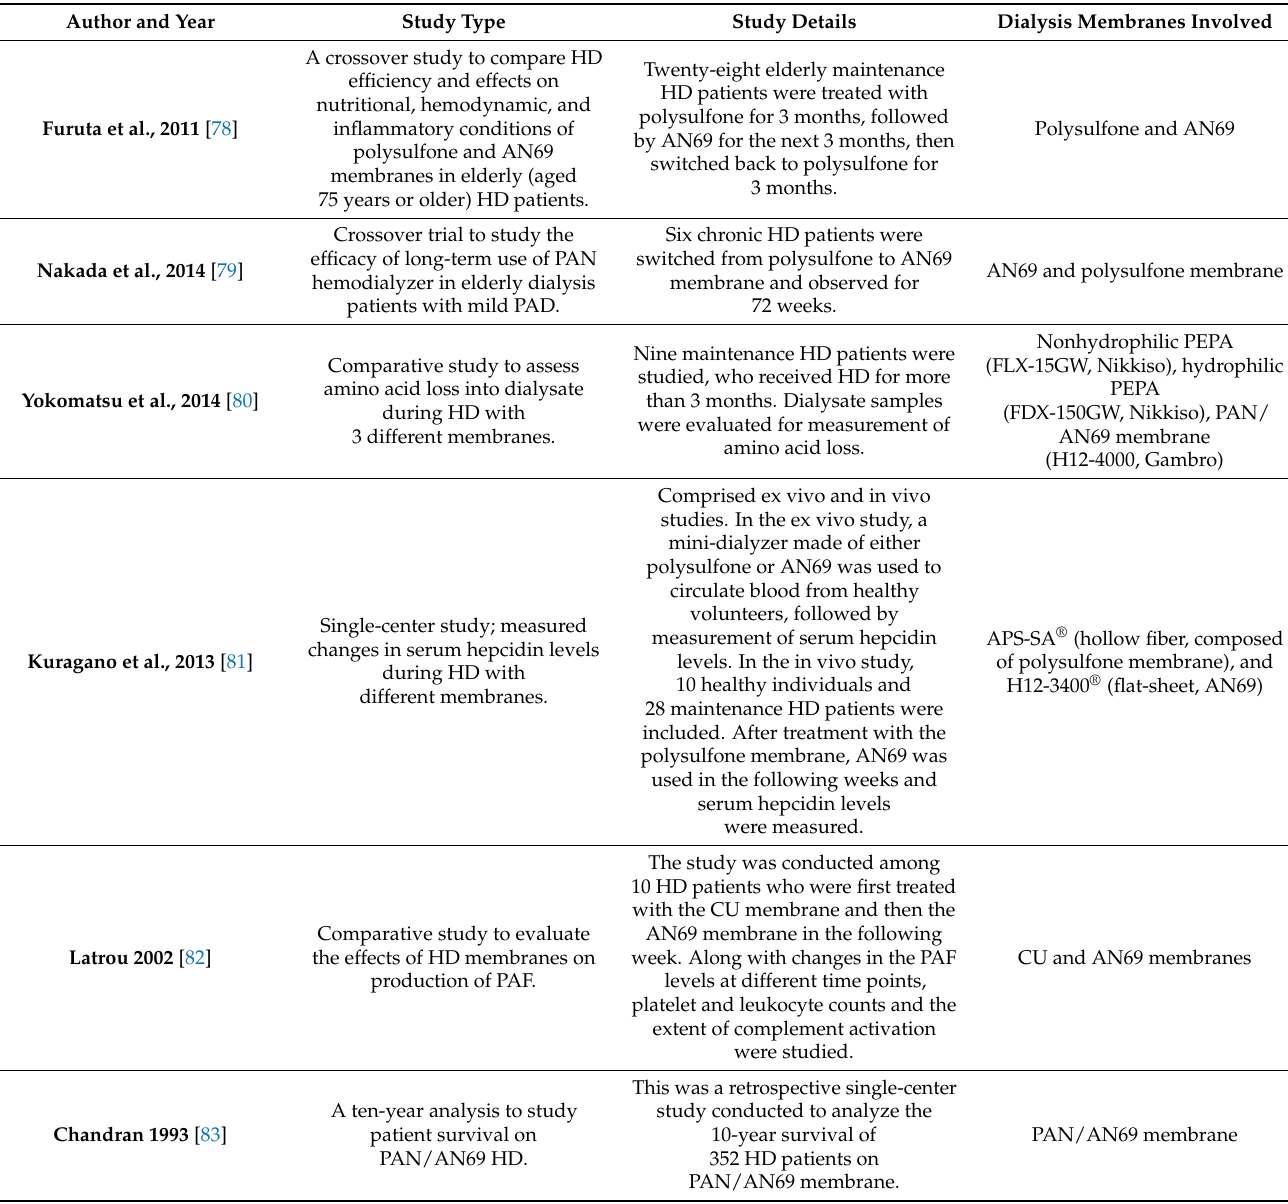
Table 2. Membrane in chronic hemodialysis